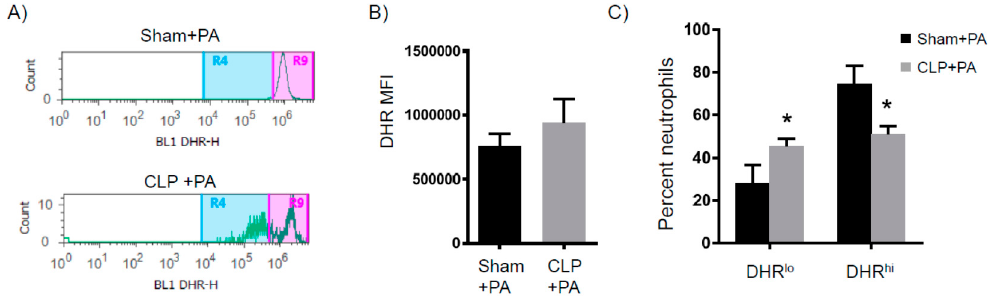
Figure 8. BAL neutrophil oxidative burst in response to pulmonary infection one week after CLP. Mice were subjected to either sham surgery ( N = 8) or CLP ( N = 12). Eight days later, all mice were inoculated with 10 6 CFU of Pseudomonas aeruginosa intranasally. Two hours later, BAL cells were analyzed for oxidative burst. ( A ) Representative flow cytometry histograms of the two distinct populations. The BAL neutrophils were then analyzed for ( B ) total DHR levels and ( C ) percent of neutrophils with low versus high DHR. * p < 0.05 versus sham.